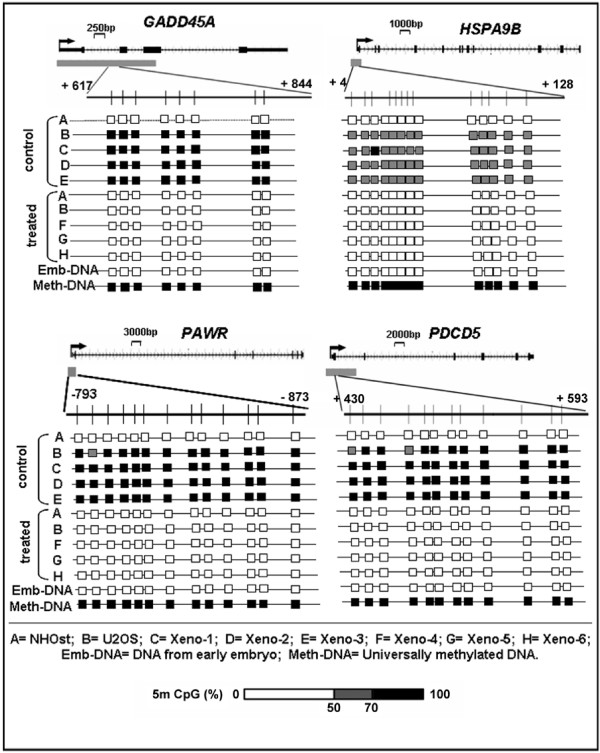
Summary of Pyro-Q-CpG findings. Illustrated are the summary findings by Pyro-Q-CpG analysis of U2OS cells in vitro without treatment (control) and with 1 μM decitabine treatment (treated). The illustration also summarizes Pyro-Q-CpG findings in control U2OS xenograft tumors (Xeno-1, Xeno-2, and Xeno-3), and 2.5 mg/kg decitabine treated U2OS xenograft tumors (Xeno-4, Xeno-5, and Xeno-6). DNA from NHOst (normal low-passage human osteoblasts) was also analyzed for experiment control. DNAs from early embryonic DNA (Emb-DNA) and universally methylated DNA (Met-DNA) were used for negative and positive control respectively. CpG-islands are denoted by grey rectangles relative to the gene start site. The region further enlarged below corresponds to each tested CpG sequence. The tick marks denotes the individual CpG dinucleotides. The transcription start site is indicated by a directional arrow with the base pair numbers annotated for each tested sequence. The extent of methylation is represented by the scale bar (bottom right). GADD45A, PAWR, and PDCD5, had a high level of methylation before decitabine treatment while HSPA9B had an intermediate level of methylation before treatment. In all cases the methylation was decreased significantly (p < 0.001) as a result of decitabine treatment. The detailed results for all genes are shown in [Additional file 4].